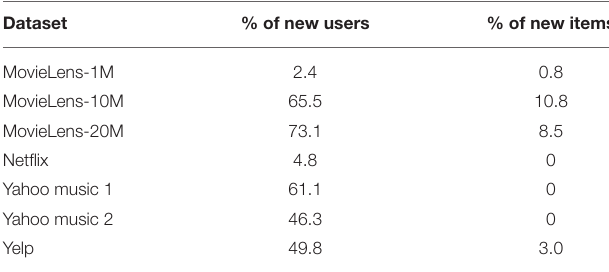
FIGURE 17 | Model structure of NCF.